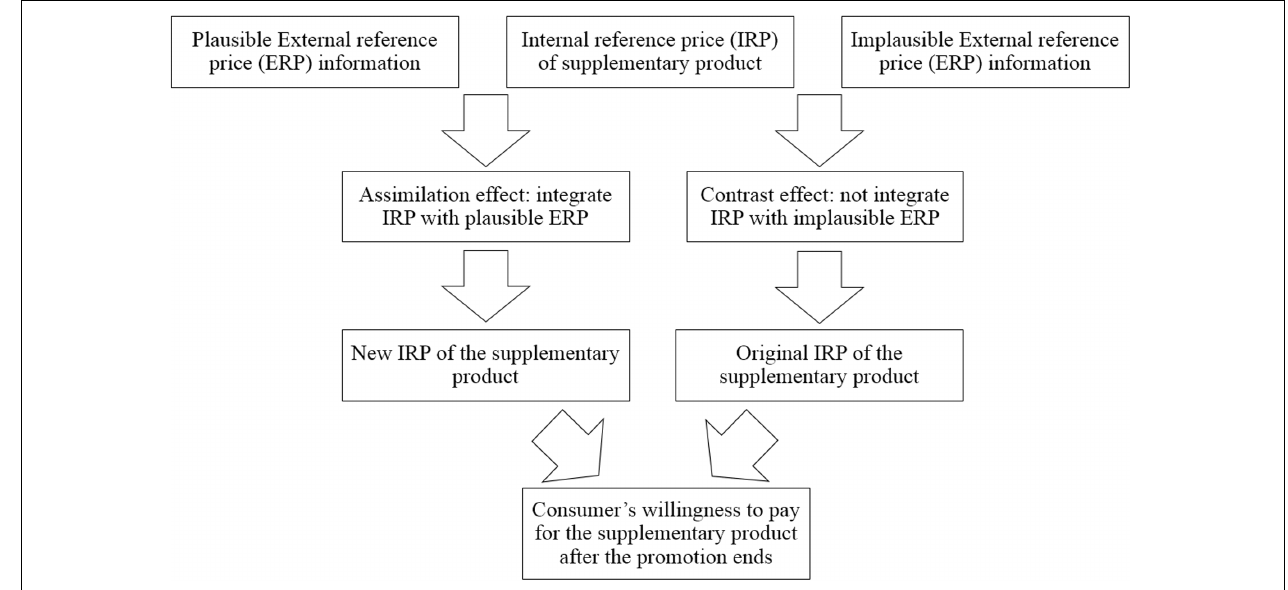
FIGURE 1 | The complete conceptual